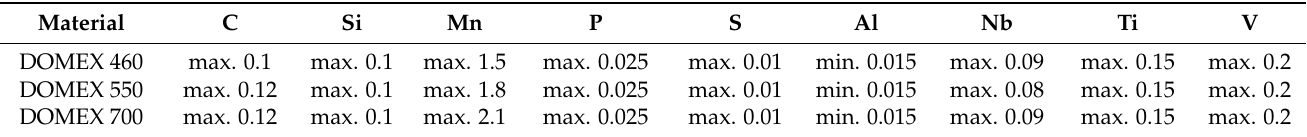
Table 2. Metal analysis of the SSAB DOMEX steels used. The content of the elements is provided in wt.% (SSAB datasheets) [31–33].